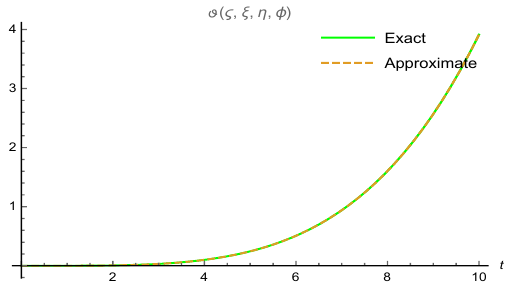
Figure 6. Graphical error between the approximate and precise results of ϑ ( ς , ξ , η , φ ) . Table 3. Absolute error between the approximate and exact solutions for Example